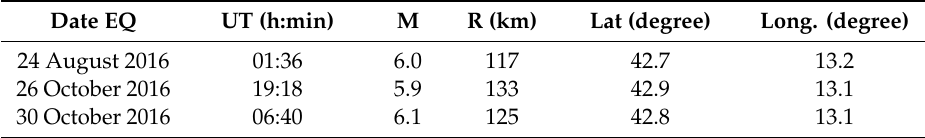
Table 1. List of the shallow earthquakes (EQs) with magnitude M ≥ 6.0 registered in Central Italy in 2016. Geographical coordinates of the EQ epicenters from the Centro Nazionale Terremoti of the Istituto Nazionale di Geofisica e Vulcanologia (INGV-CNT) (http: // cnt.rm.ingv.it / ) and the epicentral distance (R) from the Rome ionosonde are